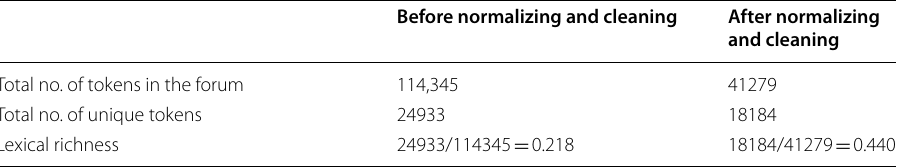
Table 2 Lexical richness of the forum before and after normalizing and cleaning Before normalizing and cleaning After normalizing and cleaning Total no. of tokens in the